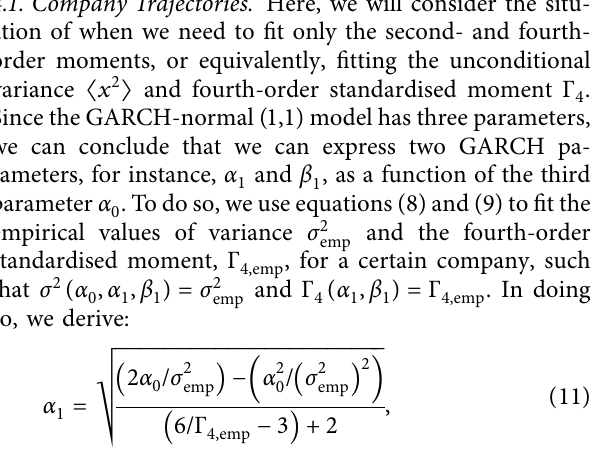
, β values that 1 1 , β values that allow 1 1